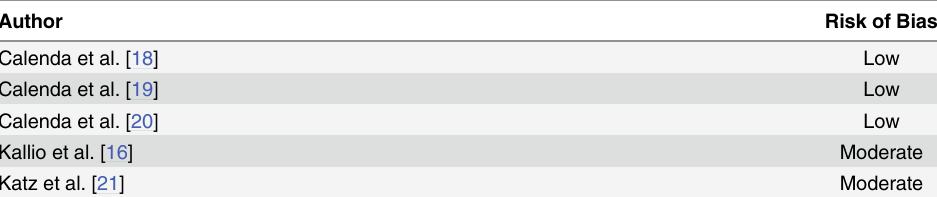
Table 2. Risk of bias: concise